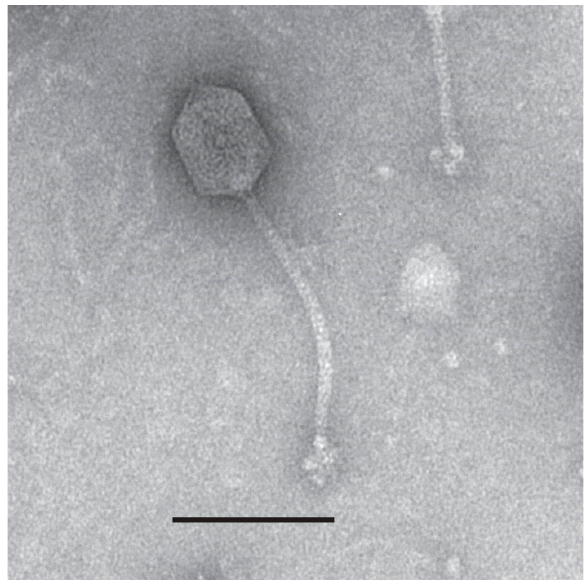
Figure 14. Transmission electron micrograph of phage Arae, negatively stained with 2% w/v uranyl acetate. The scale bar represents 100 nm.